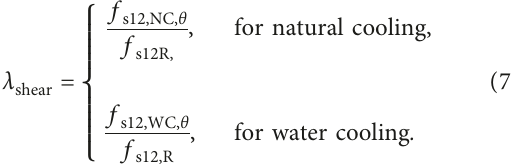
exposure (cid:31)